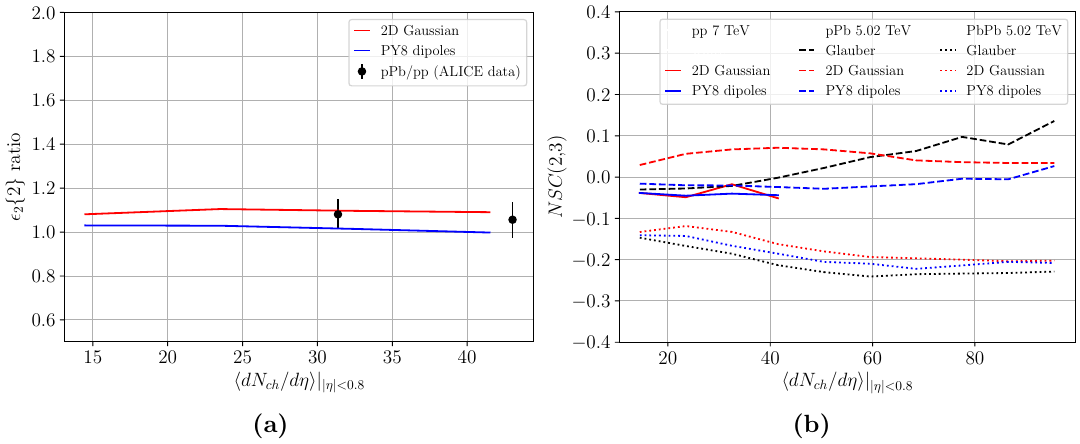
Figure 13. (a) The ratio of second order eccentricities obtained in pPb w.r.t. the baseline pp sample using the Gaussian (red) and dipole (blue) models. Data points calculated from ALICE (cid:12)gures [77]. (b) The normalized symmetric cumulants NSC (3 ; 2) for pp ; pPb ; PbPb collisions (solid, dashed, dotted, respectively) using the Glauber (black), Gaussian (red) and dipole (blue)